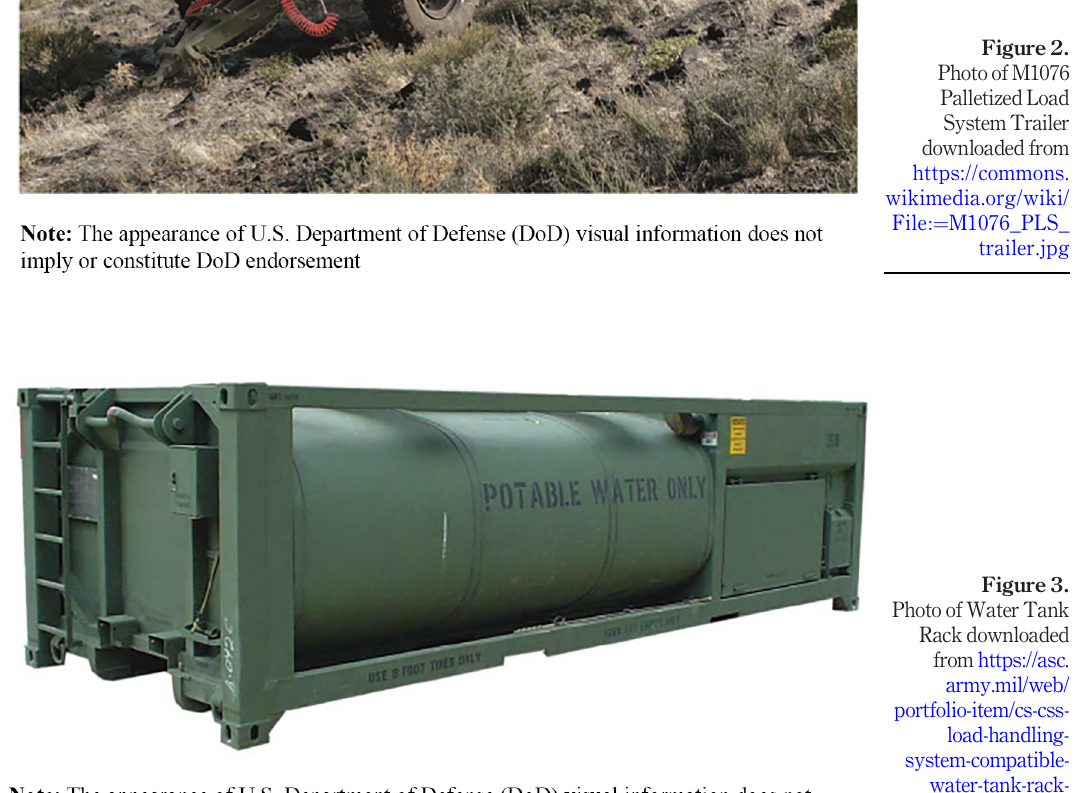
Figure 2. Photo of M1076